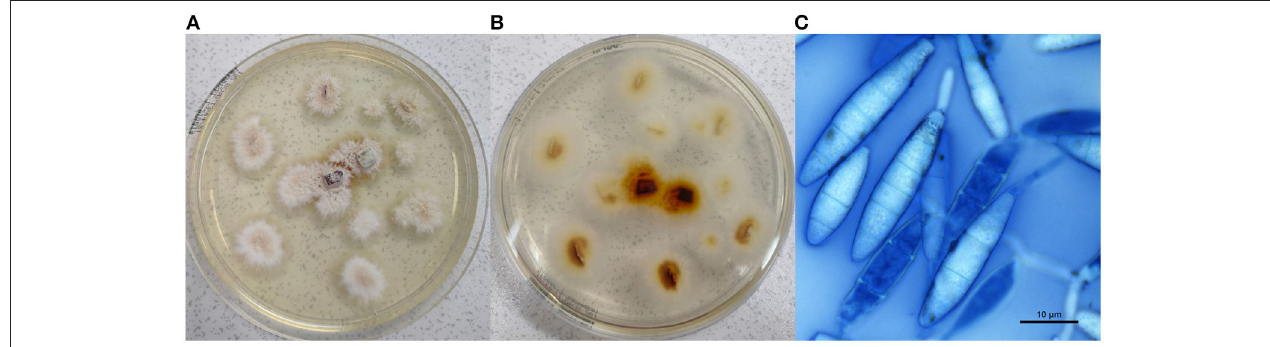
FIGURE 2 | Culture examination. (A) Macroscopic appearance of the colonies; (B) reverse of the macroscopic colonies; (C) microscopic view of Nannizzia gypsea , showing hyaline, multiseptate and fusiform thin-walled macroconidia (methylene blue stain, × 100, bar 10 µ m).